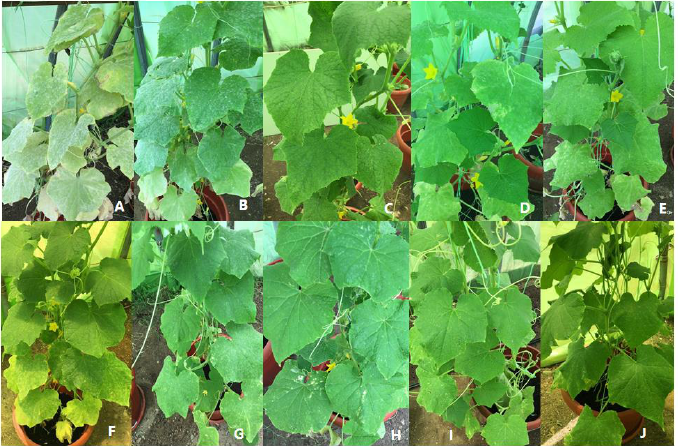
Figure 4. Untreated cucumber plants infected with powdery mildew ( A ) and plants treated with distilled water + tween ( B ), the oil mixture ( C ), lemon oil ( D ), lemongrass oil ( E ), thyme oil ( F ), peppermint oil ( G ), thieves-blend oil ( H ), abundance-blend oil ( I ), and the purification blend ( J ).